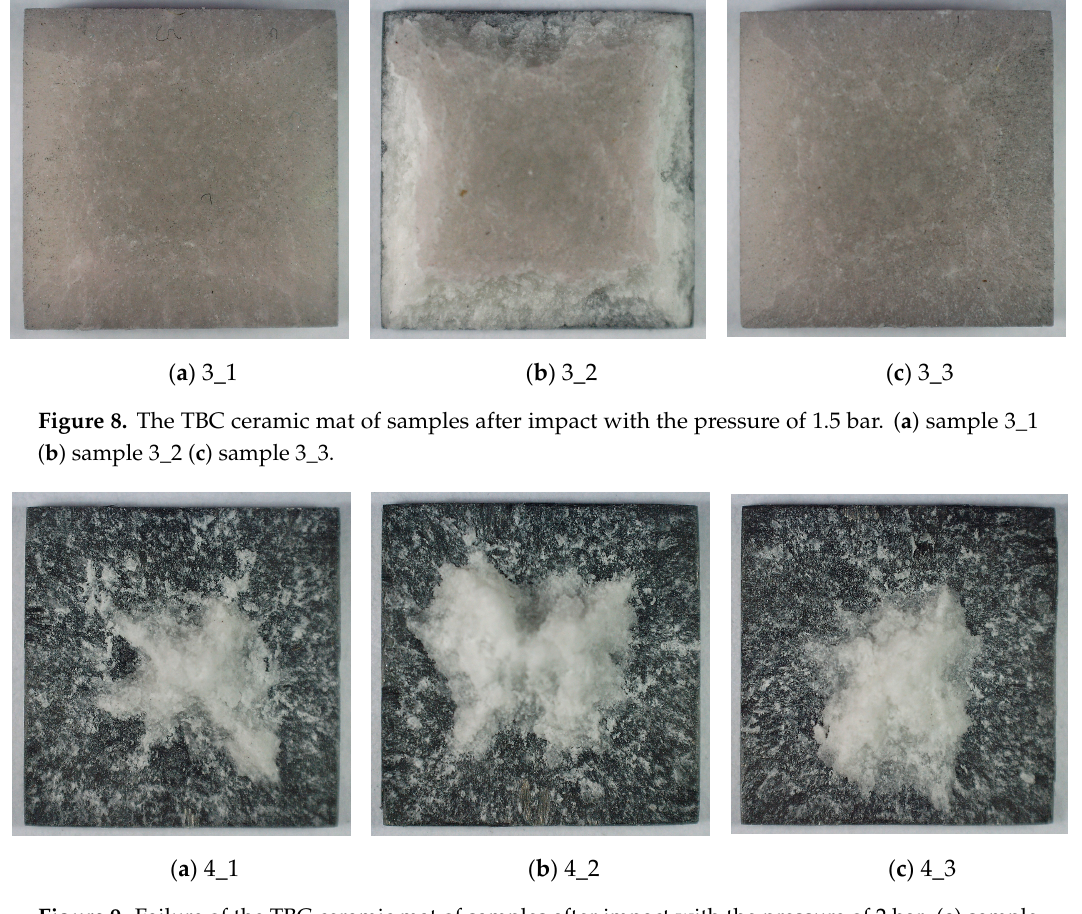
Figure 9. Failure of the TBC ceramic mat of samples after impact with the pressure of 2 bar. ( a ) sample 4_1 ( b ) sample 4_2 ( c ) sample